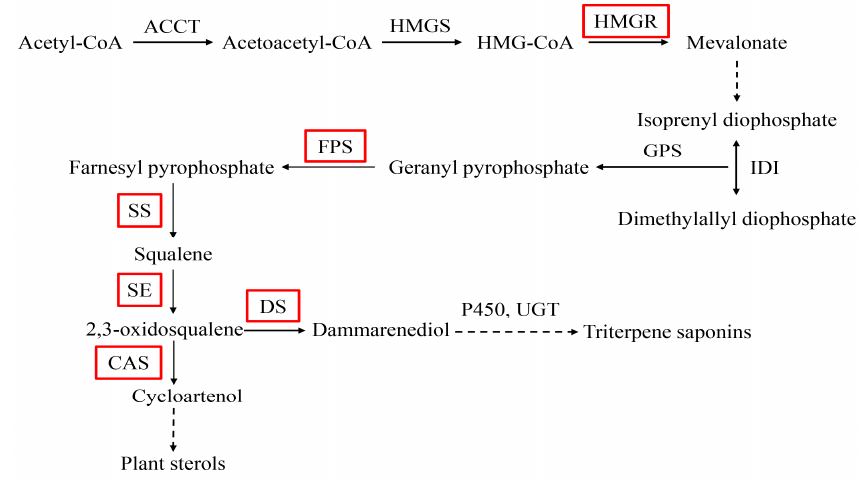
Figure 1. Biosynthetic pathway of triterpene saponins in P. notoginseng . AATC: acetoacetyl-CoA acyltransferase; HMGS: 3-Hydroxy-3-methylglutaryl-CoA synthase; HMGR: 3-hydroxy-3-methylglutaryl-CoA reductase; IDI: isopentenyl diphosphate isomerase; GPS: geranylgeranyl pyrophosphate synthase; FPS: farnesyl diphosphate synthase; SS: squalene synthase; SE: squalene epoxidase; DS: dammarenediol-II synthase; P450: cytochrome P450; UGP: UDP giycosyltransferase; CAS: cycloartenol synthase. The dotted lines indicate several enzyme reactions. The red boxes represent the key enzymes.